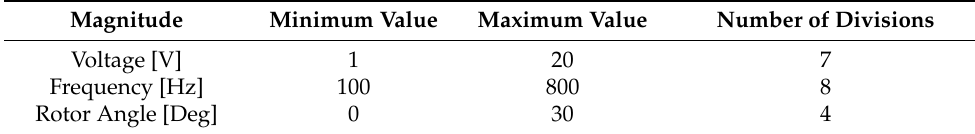
Table 2. Relevant parameters to discretize the voltage, frequency and rotor